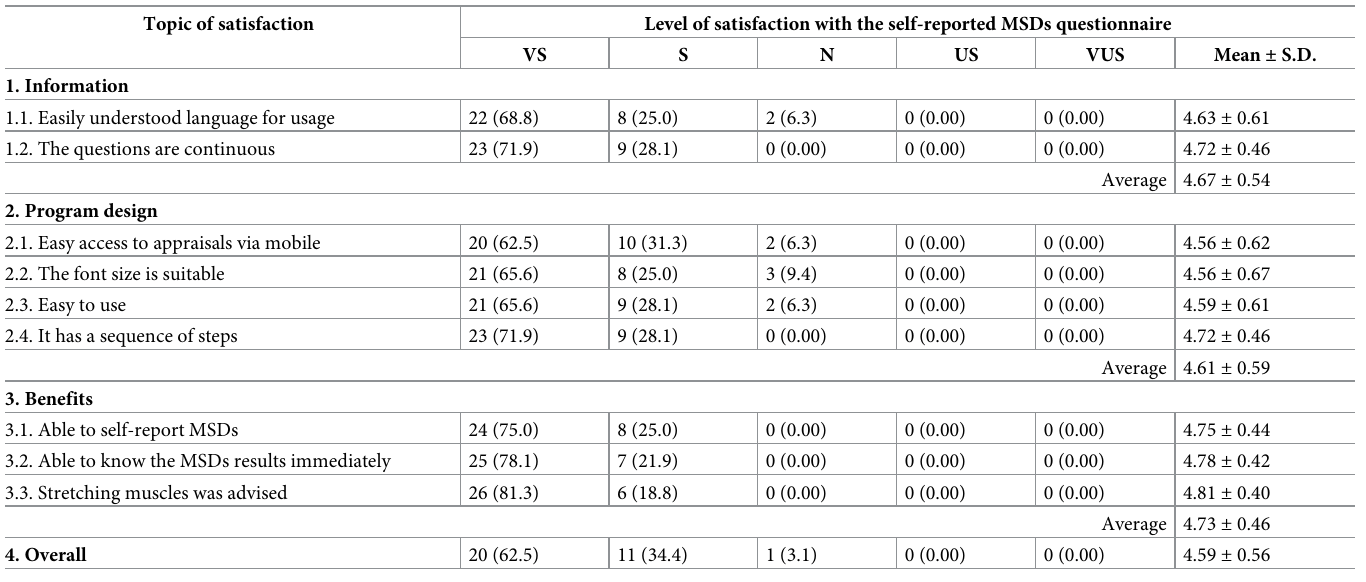
Table 1. Number (%) of users based on level of satisfaction with the online MSFQ. Topic of